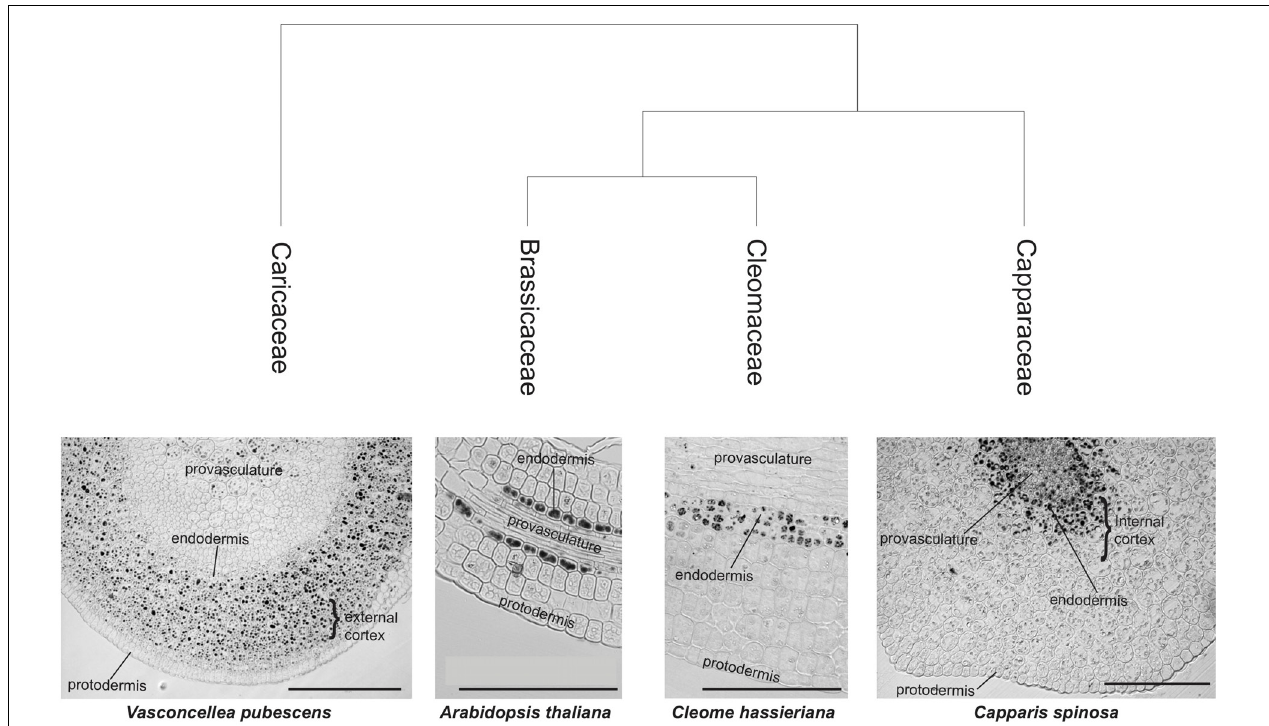
FIGURE 1 | Iron distribution in Brassicales embryos. Iron distribution in hypocotyls of four Brassicales species were mapped on the phylogenetic tree modified from Hall et al. (2004). The analysis of sections using Perls/DAB of Brassicaceae family species was previously described in Ibeas et al. (2017). Iron is accumulated, in addition to endodermis, in the cortex cells (internal cortex, close to endodermis, and close to the protodermis, external cortex). A section of A. thaliana hypocotyl stained with Perls/DAB is shown. Bars in panels correspond to 100 µ m.